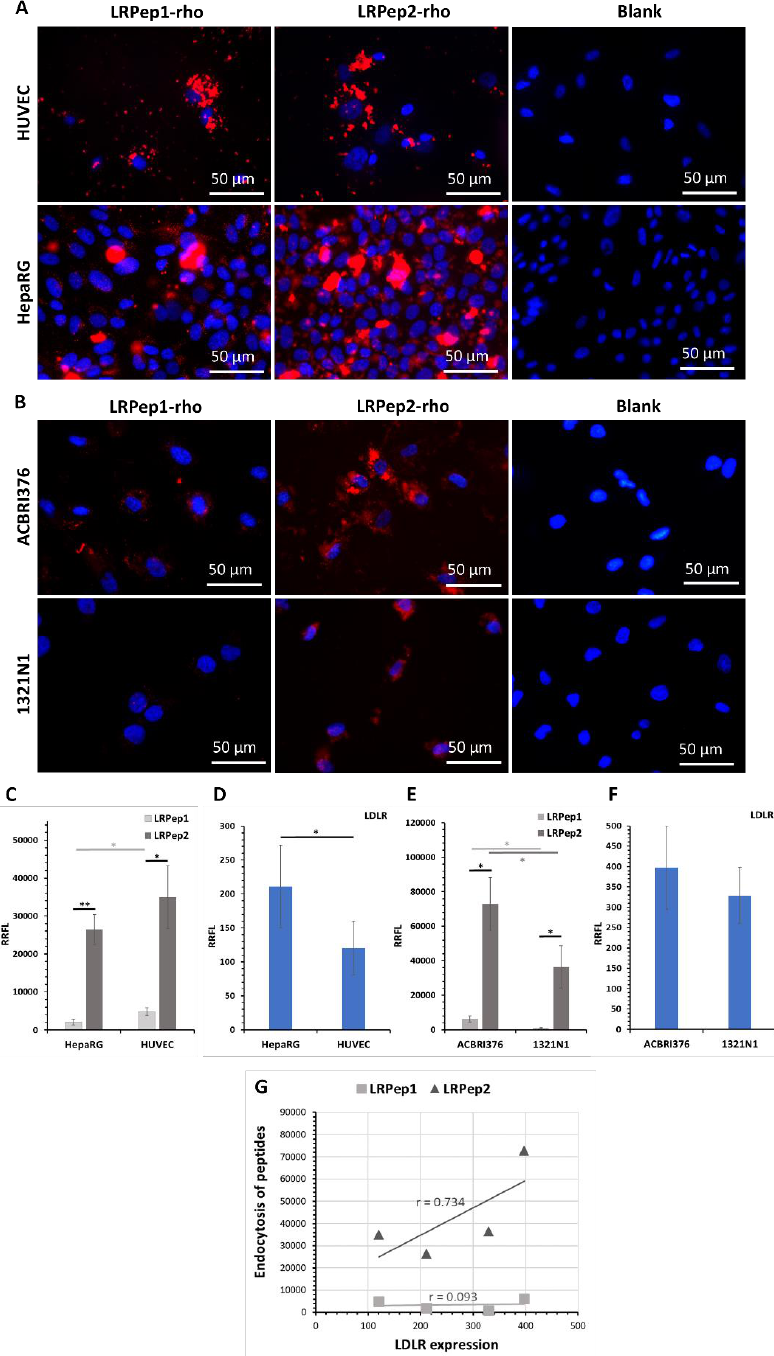
Figure 4. Endocytosis of the peptides LRPep1-rho and LRPep2-rho (stained in red) in ( A ) HUVEC and HepaRG cells and ( B ) ACBRI376 and 1321N1 cells. Nuclei are stained in blue with Hoechst. ( C – F ) The endocytosis of peptides, as well as the expression of LDLR, was semi-quantitatively evaluated by the measurement of fluorescent labeling using the ImageJ software and was normalized to the number of cells and to the background, giving the relative ratio of fluorescent labeling (RRFL); *: p < 0.05, **: p < 0.001. ( G ) The correlation coefficient between the expression of LDLR and the endocytosis of peptides.